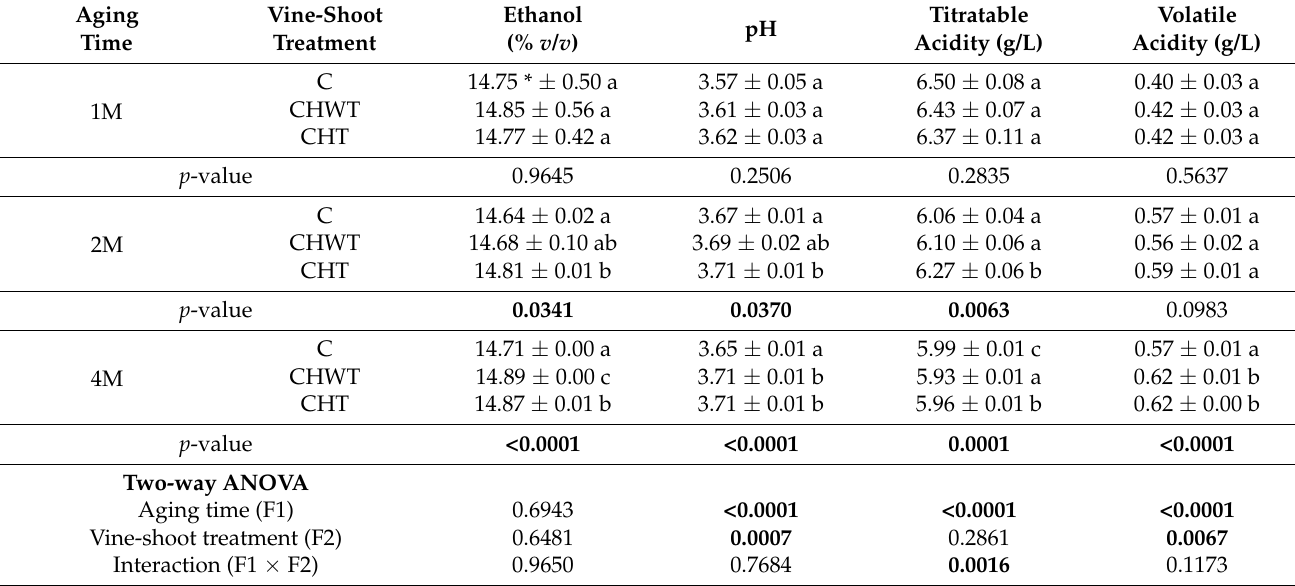
Table 3. Basic chemical parameters of Bonarda wines obtained applying vine-shoot chips during aging (Experiment B). Aging